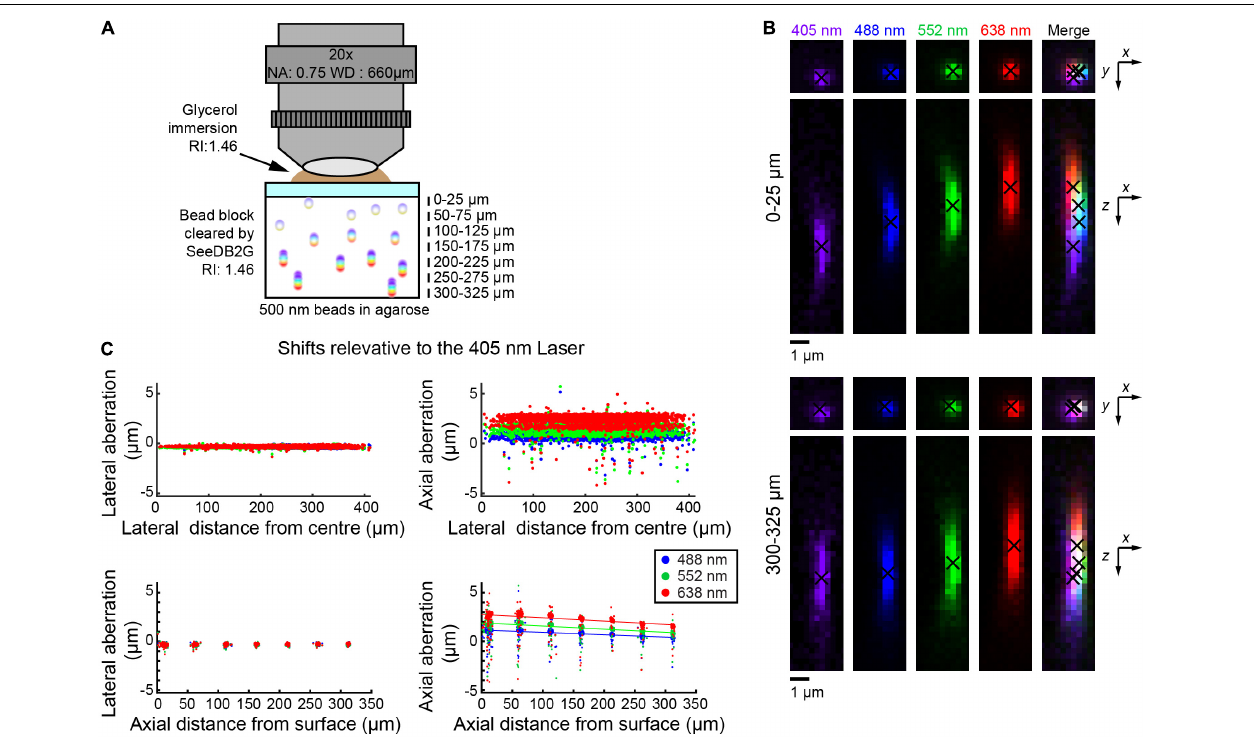
FIGURE 3 | Measuring chromatic aberrations with a multi-immersion objective lens (Leica 20 × ). (A) Fluorescent beads (500 nm) were embedded in agarose gel and then cleared with SeeDB2G (RI, 1.46). The agarose sample was mounted with a 0.17 mm thick coverslip. Glycerol (RI, 1.46) was used for immersion. (B) High-magnification images of fluorescence beads at representative depths (MIPs). Centroid positions are indicated by black crosses. (C) Lateral and axial chromatic aberrations at 488, 552, and 638 nm were determined as shifts relative to the 405 nm laser. Positive axial aberration values indicate that the bead is higher than it appears in the 473 nm image. Depth-dependent axial aberrations were